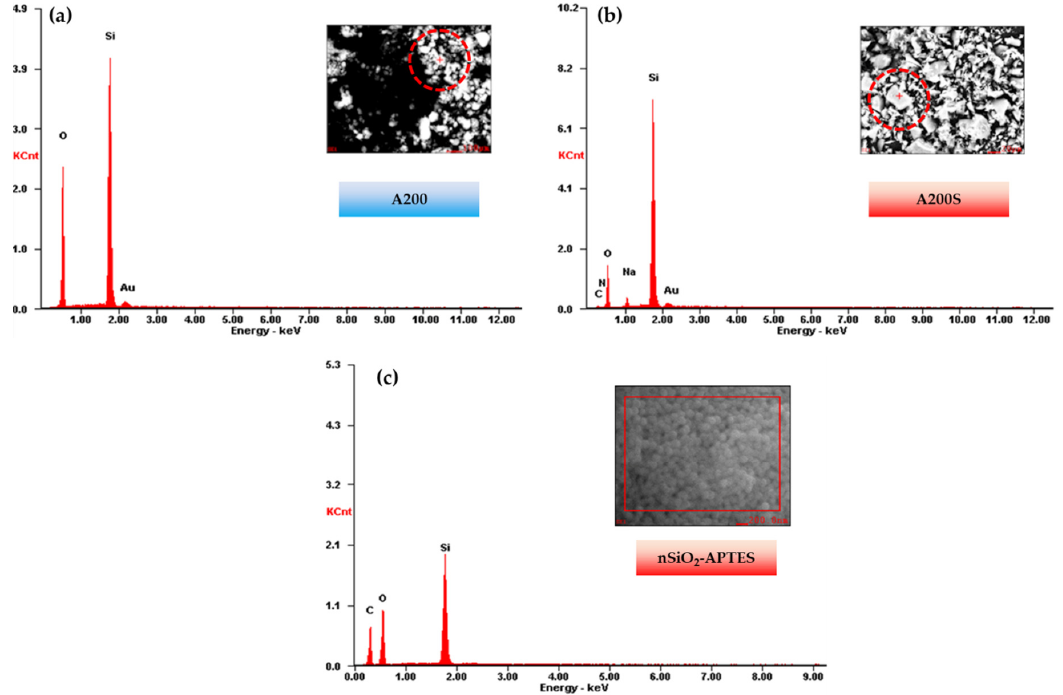
Figure 5. EDS results of ( a ) A200, ( b ) A200S and ( c ) nSiO 2 -APTES NPs. Table 1. Weight and atomic percentage of A200, A200S and nSiO 2 -APTES S NPs by EDS analysis.